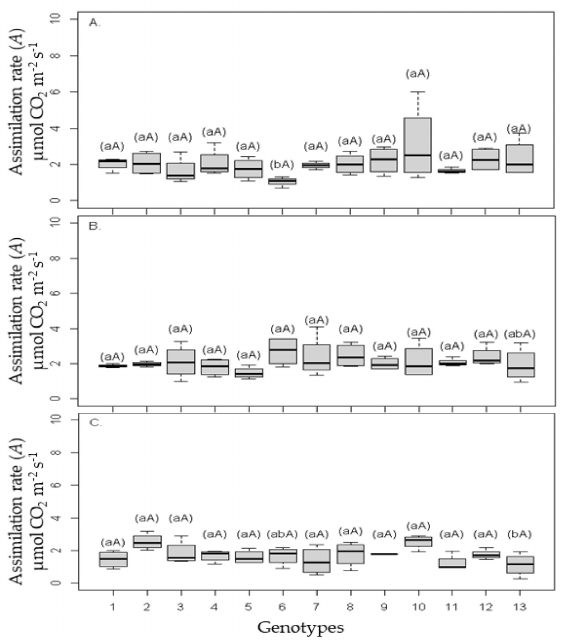
Figure 14. Boxplot relative to the assimilation rate ( A ) of 13 citrus rootstocks in combination with ‘Tahiti’ acid lime ( Citrus × latifolia (Yu. Tanaka) Tanaka) under irrigation with waters of 0.14 ( A ), 2.40 ( B ), and 4.80 dS m − 1 ( C ), in the second year. For identification of genotypes, see Table 1.